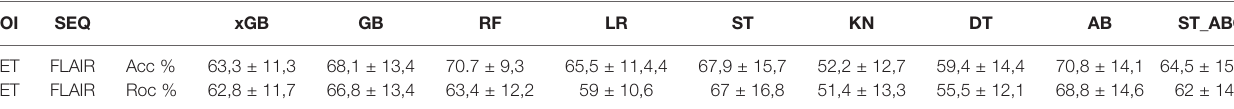
TABLE 3 | MGMT best results (reported as mean ± standard deviation).